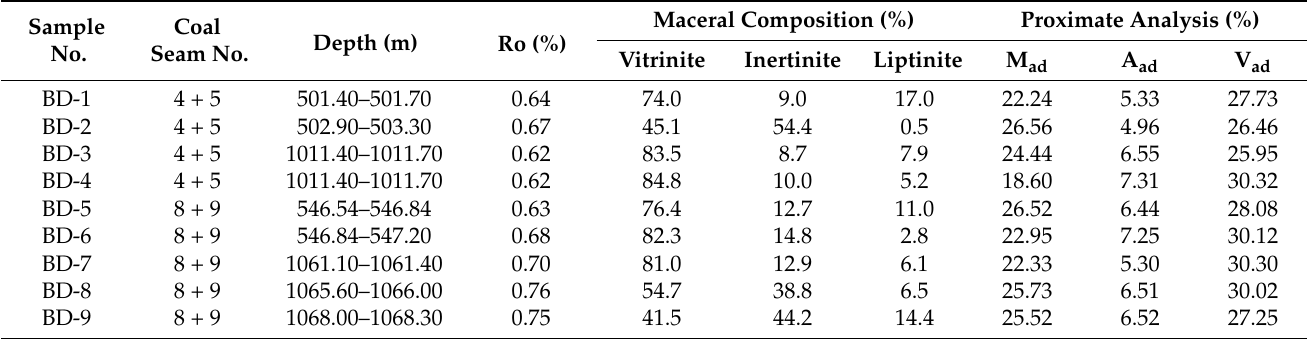
Table 1. Results of the proximate and maceral